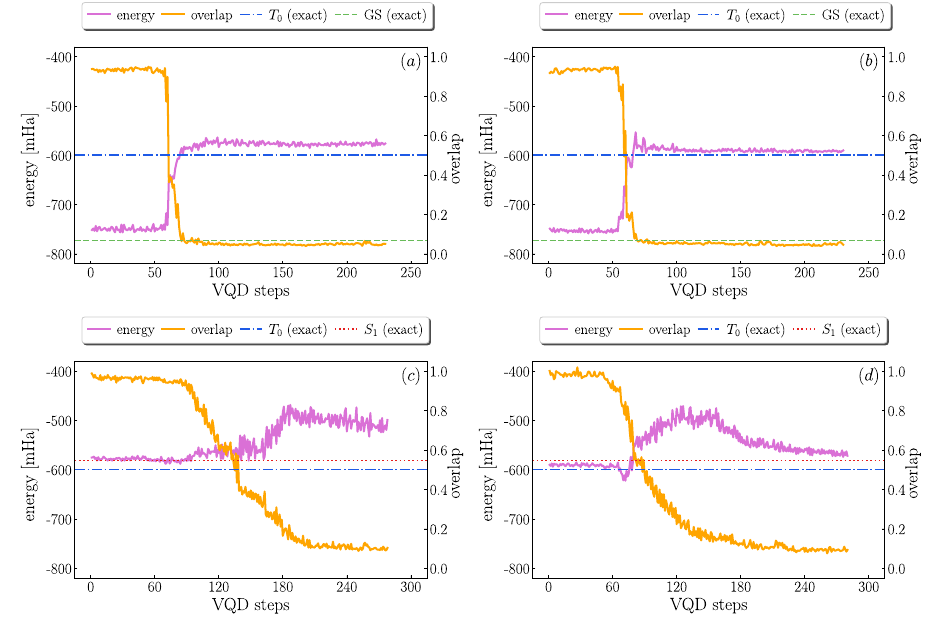
Fig. 5 VQD iterations for calculations of 2F-PSPCz with the SPSA optimizer on ibmq_singapore . a T 1 using the unpuri fi ed reference state, b T